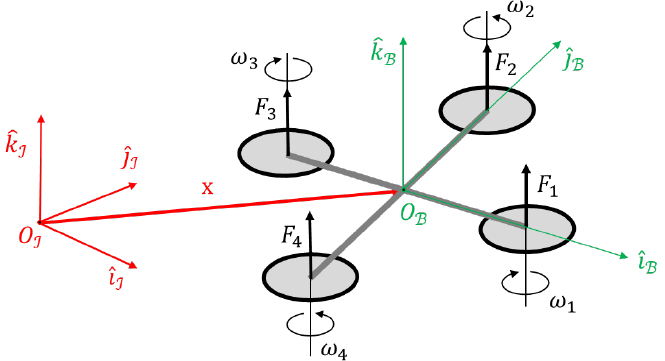
Figure 1. Quadrotor dynamics reference frames: inertial frame (red) and body frame